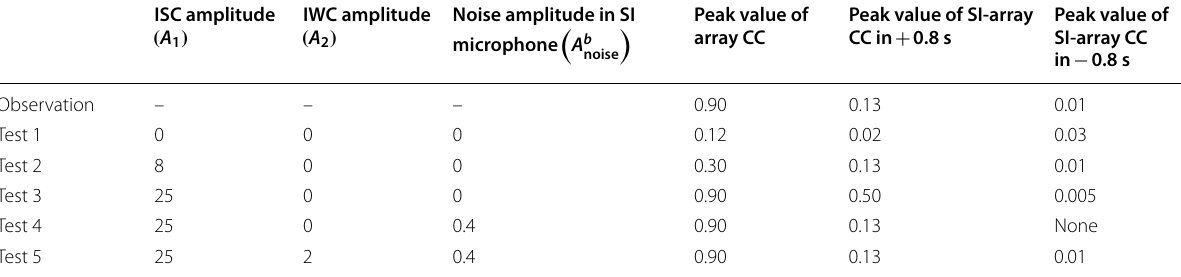
The noise amplitudes in Eq. 5 are fixed as A n noise = 0 ( n = A1, A2, A3 ) , and A k =